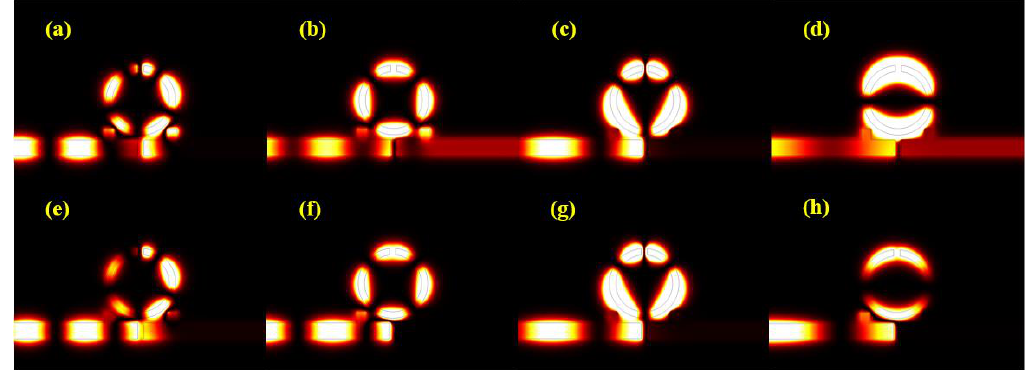
Figure 3. ( a – h ) The distributions of magnetic field intensity (| Hz | 2 ) at λ = 548 nm (FR1 peak), 611 nm (FR2 peak), 827 nm (FR3 peak), 1154 nm (FR4 peak), λ = 539 nm (FR1 dip), 626 nm (FR2 dip), 821 nm (FR3 dip), and 1199 nm (FR4 dip).